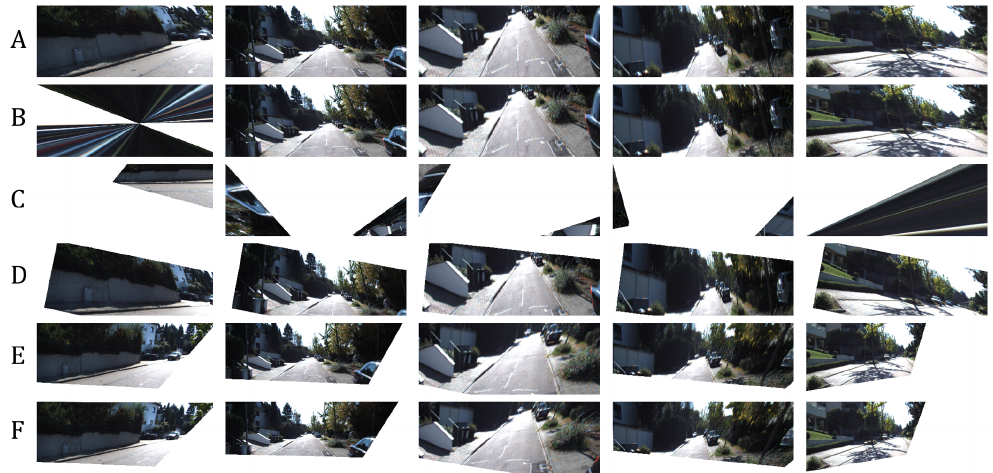
Figure A1. Additional results using unseen data from KITTI. ( A ): Distorted input images. ( B ): Corrected image using homography estimation ( C ): Corrected image using the technique of Chaudhury et al. [21]. ( D ): Corrected image using the technique of Li et al. [11]. ( E ): Corrected image using our